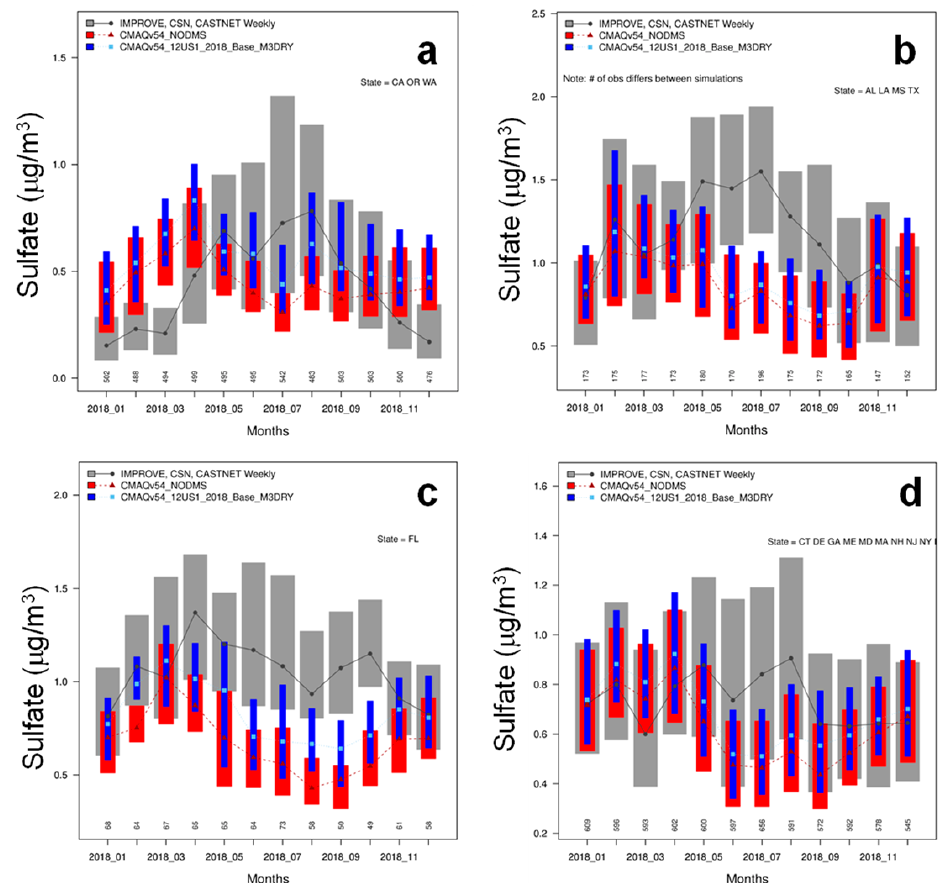
Figure 8. A comparison of predicted sulfate without and with DMS emissions to observed sulfate in ( a ) the Pacific Coast states, ( b ) the Gulf Coast states, ( c ) Florida, and ( d ) the Atlantic Coast states. Boxplot of observed sulfate (grey boxes and lines) from IMPROVE, CSN, and CASTNET; model without DMS emissions (red boxes and lines); and model with DMS emissions (blue boxes and lines) by month. The shaded box represents the interquartile range (25% to 75%) of the data and the point indicates the median value. The numbers below each box indicate the total number of observations available for that month from the three networks. See Figure 4a for the locations of monitoring sites.